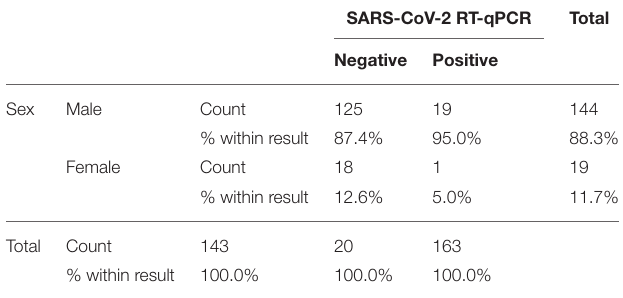
TABLE 1 | SARS-CoV-2 reverse transcription quantitative real-time PCR (RT-qPCR) test results distribution among the special forces police unit officers included in the